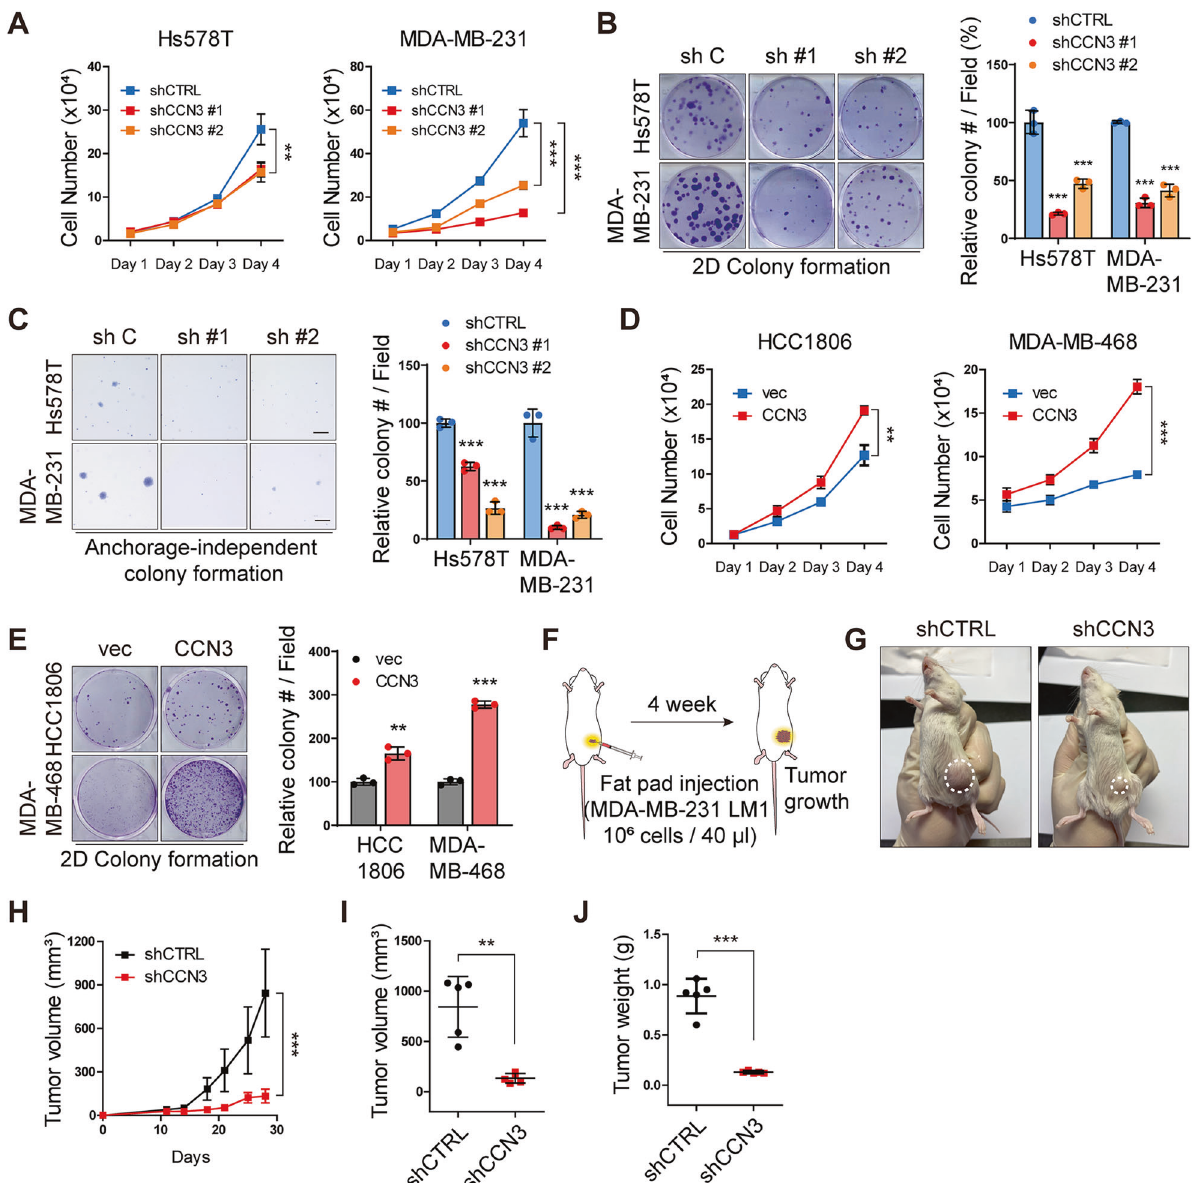
Fig. 4 CCN3 promotes cell proliferation and enhanced clonogenic ability. A Cell proliferation assays were performed with Hs578T and MDA- MB-231 CCN3 knockdown cell lines. Mean ± SD ( n = 3). P -values were calculated with two-way ANOVA with a Bonferroni posttest (** p < 0.005, *** p < 0.0005). B 2D colony formation assays were performed with Hs578T and MDA-MB-231 CCN3 knockdown cell lines. Each value was normalized with the value of shCTRL. Mean ± SD ( n = 3). P -values were calculated with one-way ANOVA with a post-hoc Dunnett ’ s multiple comparison test (*** p < 0.0005). C Anchorage-independent colony formation assays were performed with Hs578T and MDA-MB-231 CCN3 knockdown cell lines (scale bar = 50 μ m). Each value was normalized based on the value of the shCTRL. Mean ± SD ( n = 3). P -values were calculated with one-way ANOVA with a post-hoc Dunnett ’ s multiple comparison test (*** p < 0.0005). D Cell proliferation assays were performed with HCC1806 and MDA-MB-468 CCN3 overexpression cell lines. Mean ± SD ( n = 3). P -values were calculated with a two-way ANOVA with a Bonferroni posttest (n.s; not signi fi cant, ** p < 0.005, *** p < 0.0005). E 2D colony formation assays were performed with HCC1806 and MDA-MB-468 CCN3 overexpression cell lines. Each value was normalized with the value of the empty vector cell line. Mean ± SD ( n = 3). P -values were calculated with a two-tailed student t -test (n.s.; not signi fi cant, ** p < 0.005, *** p < 0.0005). F Schematic experimental procedure for fat pad injection of tumor cells. MDA-MB-231 LM1 CCN3 knockdown cell line was used for injection. G Representative images